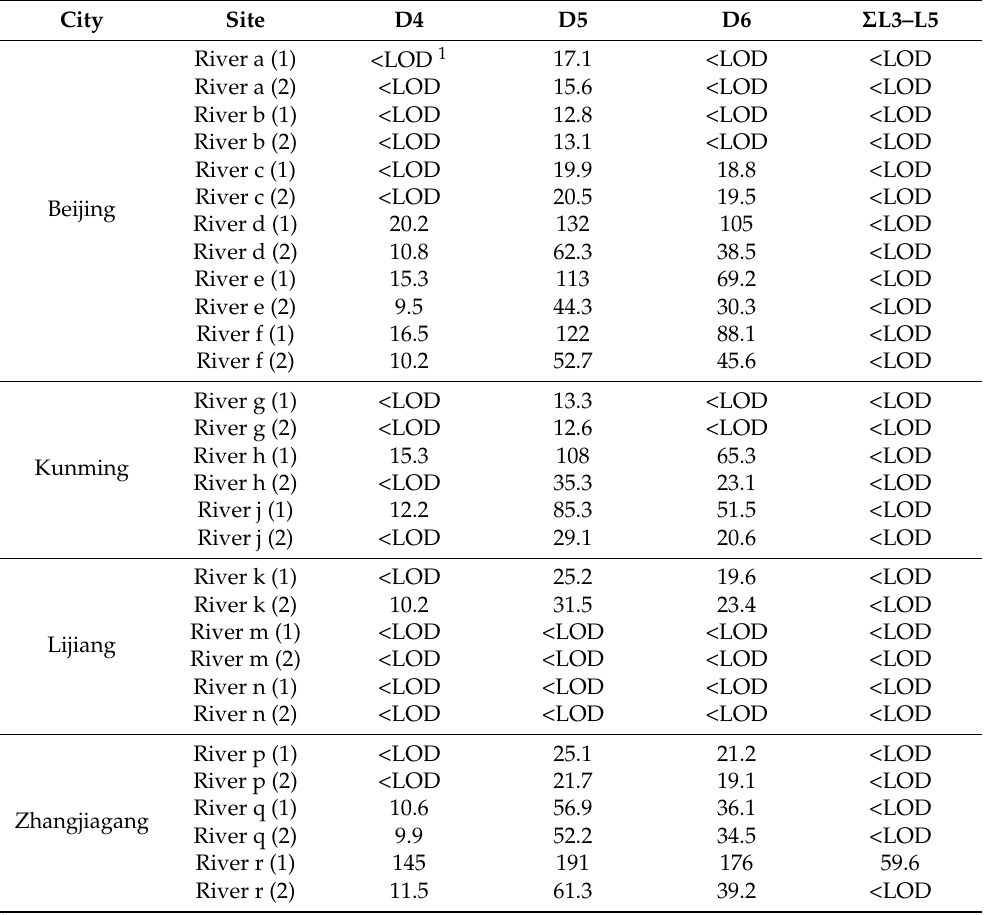
Table 2. The mean concentrations (ng/L) of methylsiloxanes in water samples from four cities. City